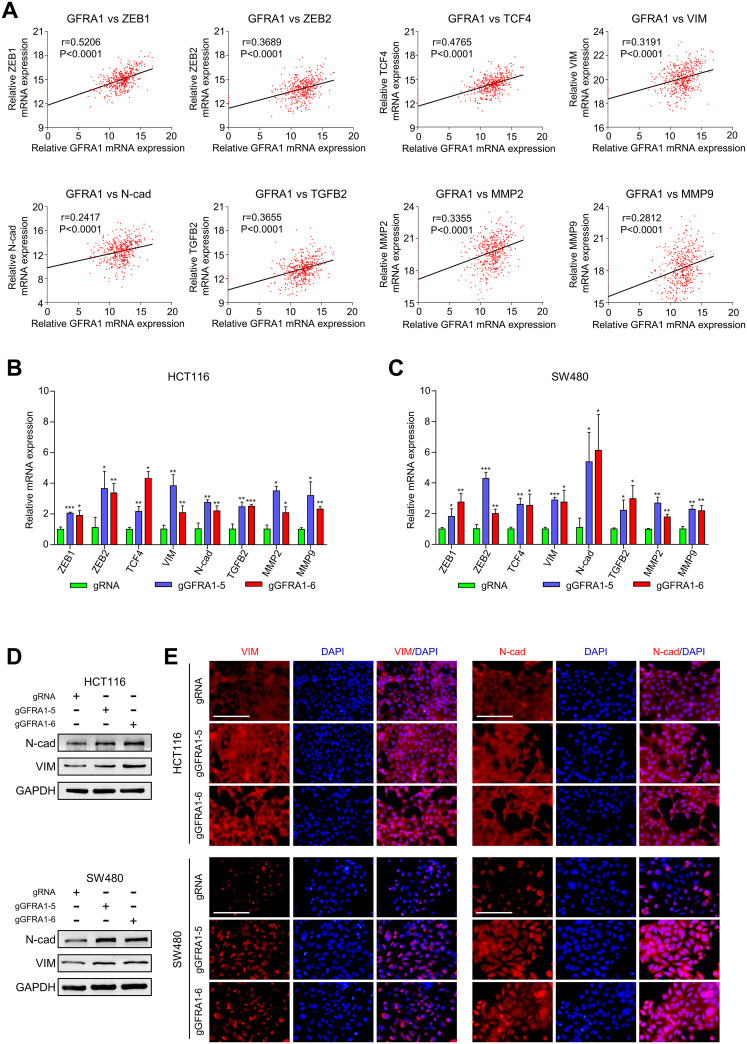
GFRA1 hypomethylation activates EMT in CRC cells.A Gene co-expression analysis showing the correlation of GFRA1 to ZEB1, ZEB2, TCF4, VIM, N-cad, TGFB2, MMP2, and MMP9 (Pearson correlation test). B-C q-PCR assays display the effects on gene expression (A) in GFRA1 hypomethylation CRC cells (*p < 0.05, **p < 0.01, ***p < 0.001; Student’s t-test). D Western blot analyses showing the effects of GFRA1-targeted demethylation on the expression of EMT marker (VIM and N-cad) proteins in CRC cells. E Immunofluorescence assays depicting localization and protein expression of EMT markers after GFRA1 demethylation. Data are mean ± SD from at least three independent experiments. Scale bars represent 100 μm.